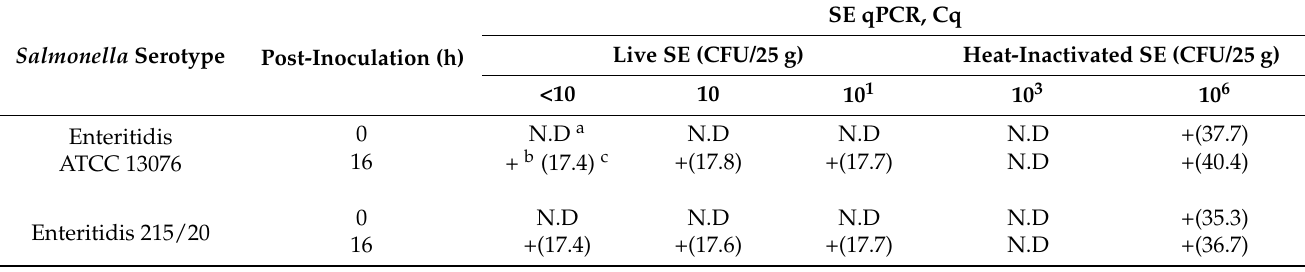
Table 2. Changes in Cq values for detection of live and heat-inactivated SE in 16 h post-inoculated artificially contaminated egg